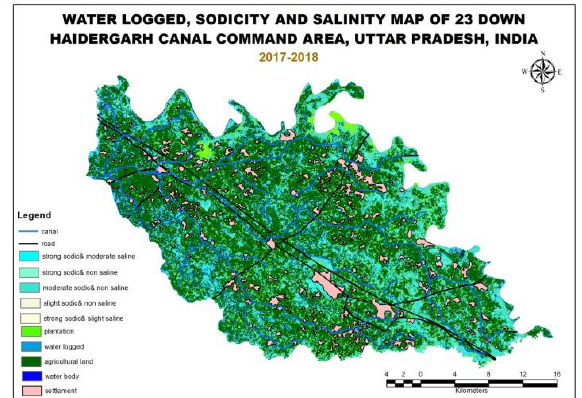
Figure 9: Land use categories by Supervised technique for the year 2017-2018